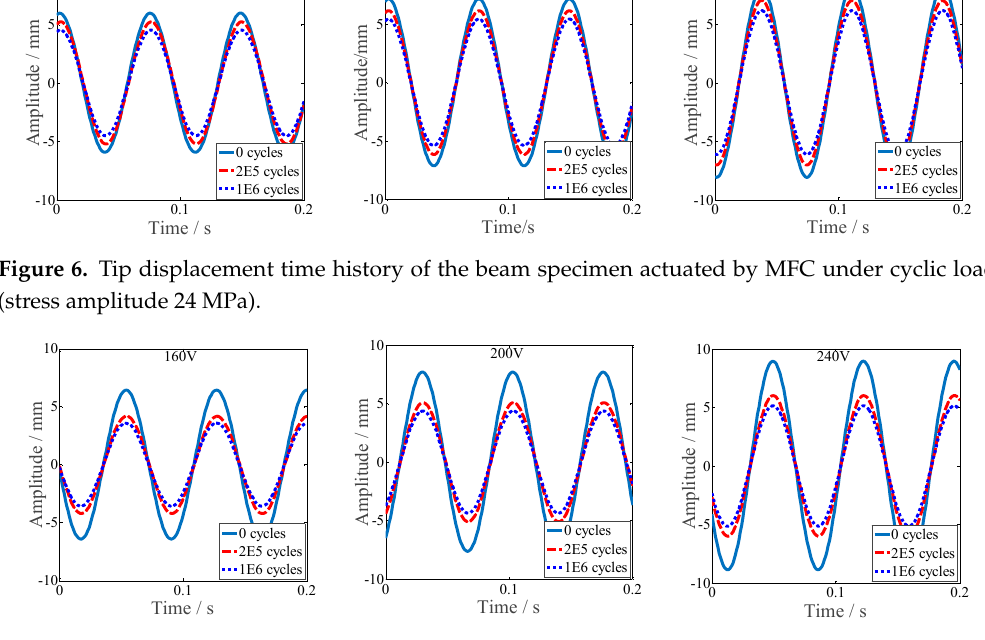
Figure 7. Tip displacement time history of the beam specimen actuated by MFC under cyclic load (stress amplitude 30 MPa).